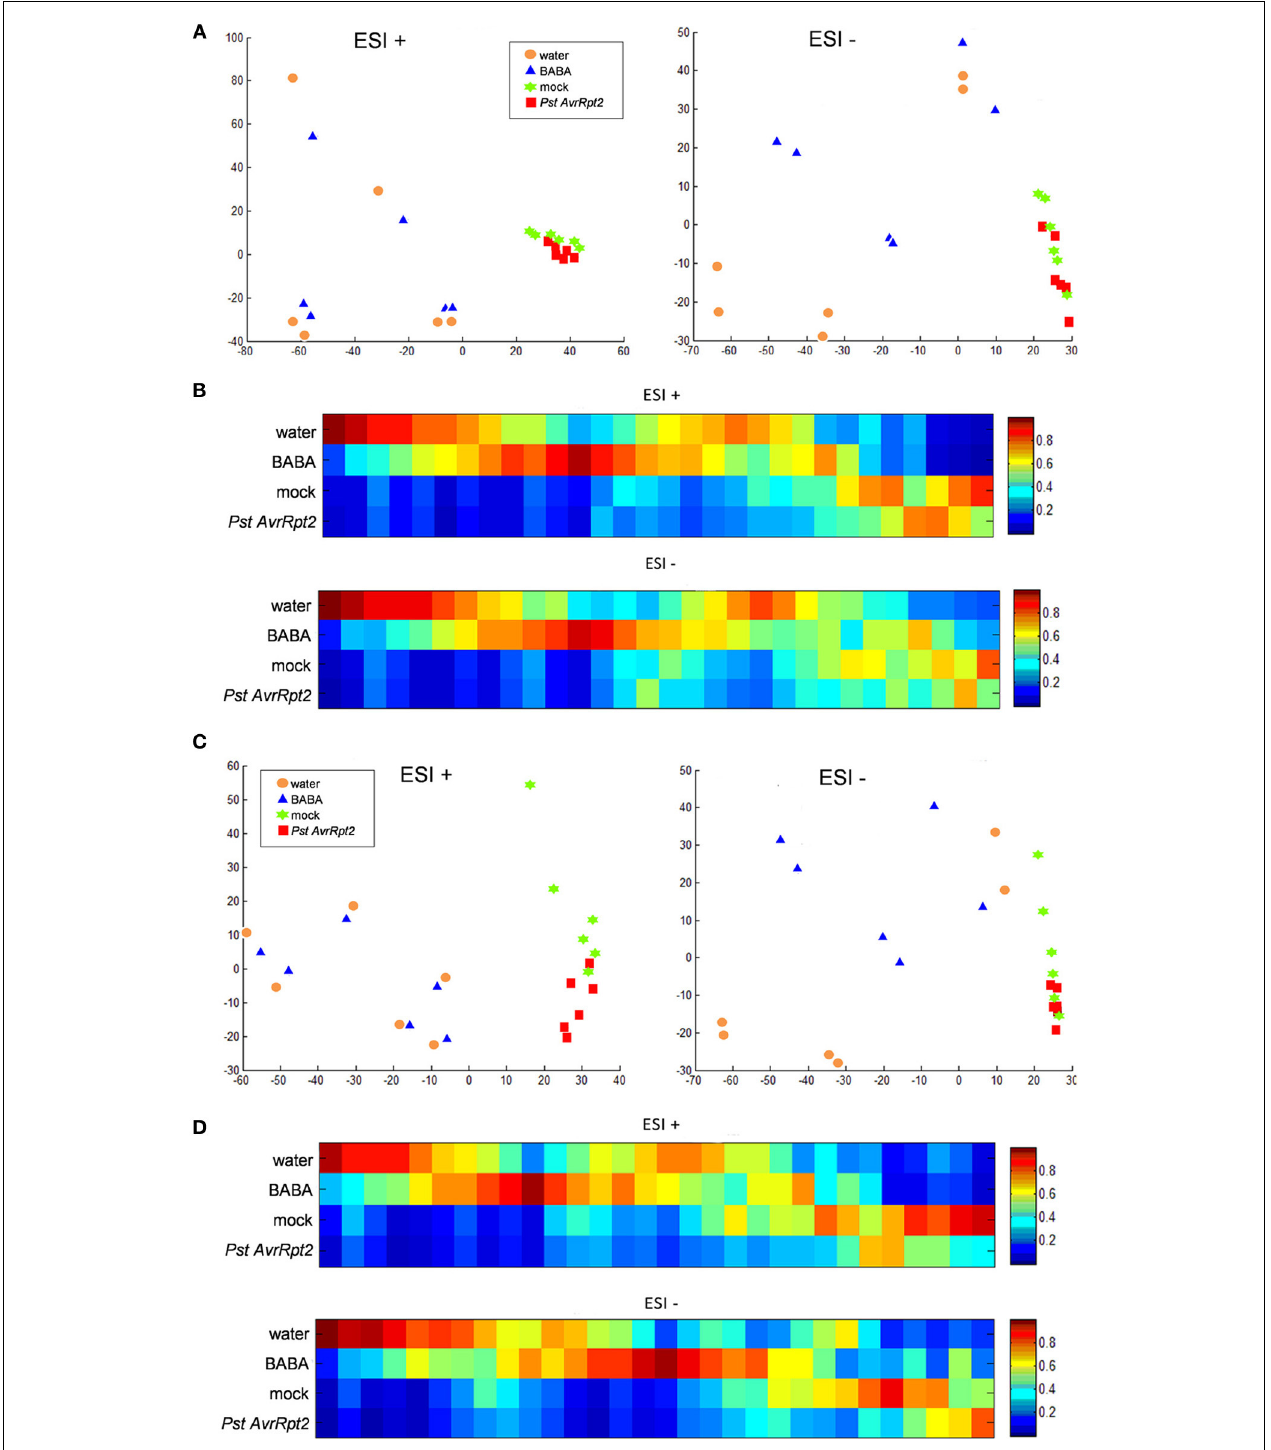
FIGURE 2 | Principal component analysis (PCA) and cluster plots comparing the four groups generated from the major sources of variable signals obtained in ESI + and ESI − by non-targeted analysis by HPLC-QTOF MS of the four groups water, BABA, mock, and PstAvrRpt2 . The PCA and cluster analyses were